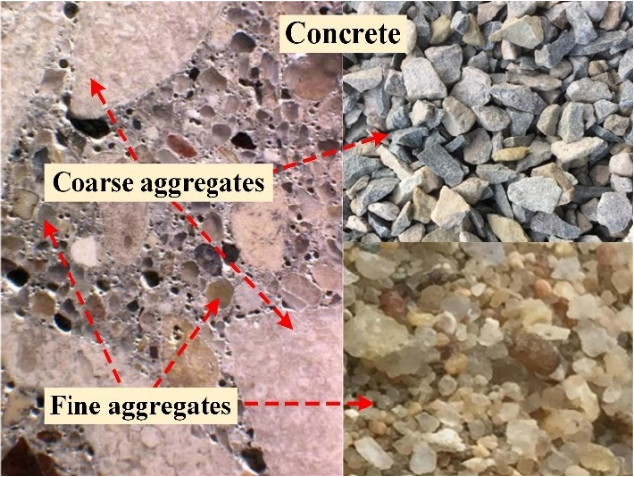
Figure 1. The morphologies of both coarse aggregates (i.e., gravels) and fine aggregates (i.e., sands) in actual concrete.